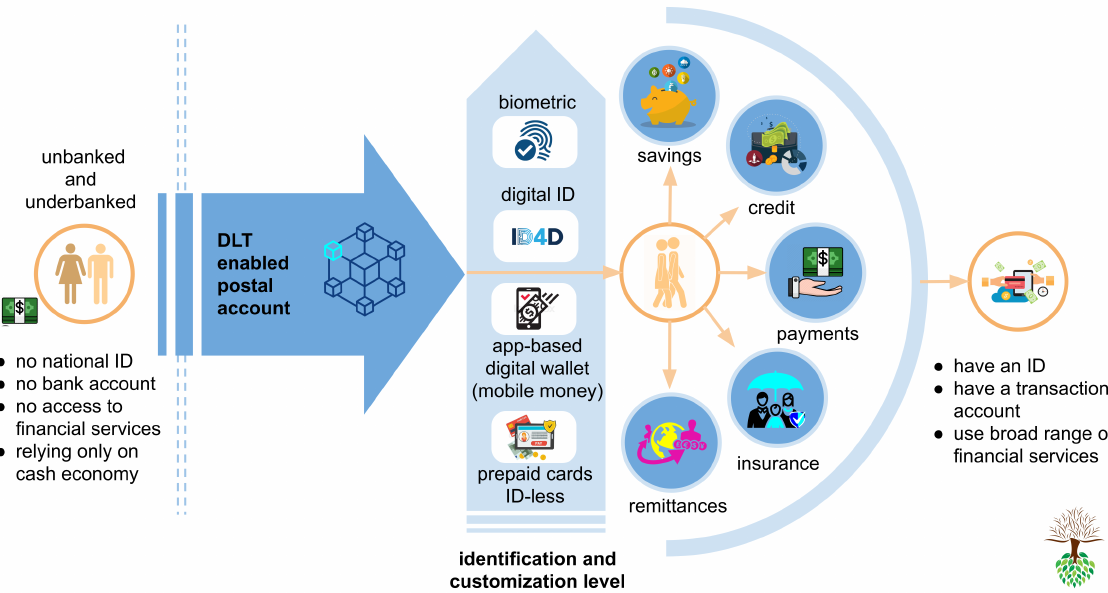
Fig. 2. DLT-enabled state-of-the-art inclusive postal financial